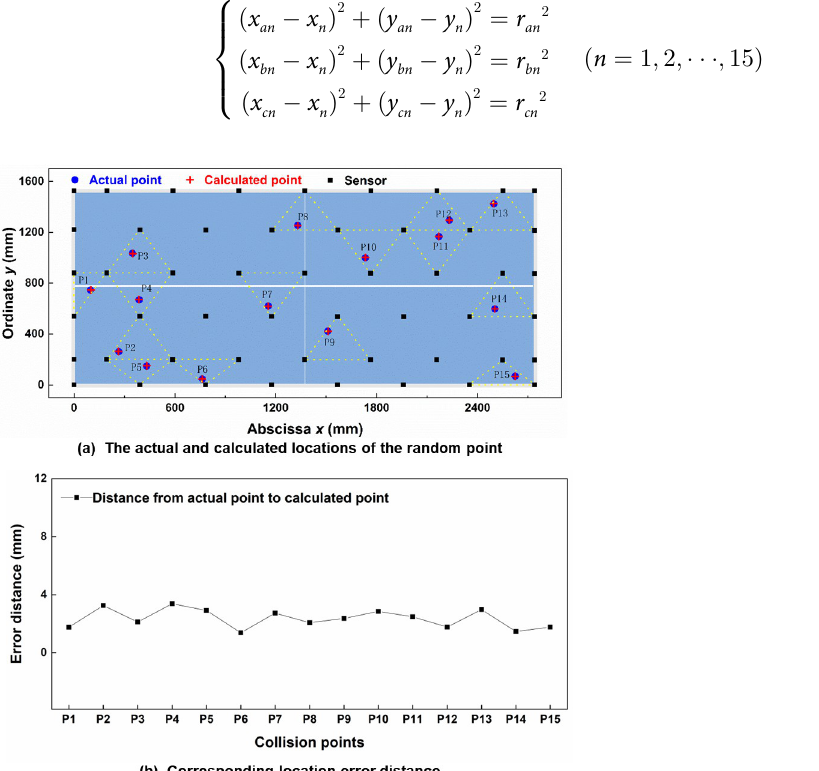
Fig 6. (a) Comparison of the calculated location and actual location of the random point and (b) corresponding location error.